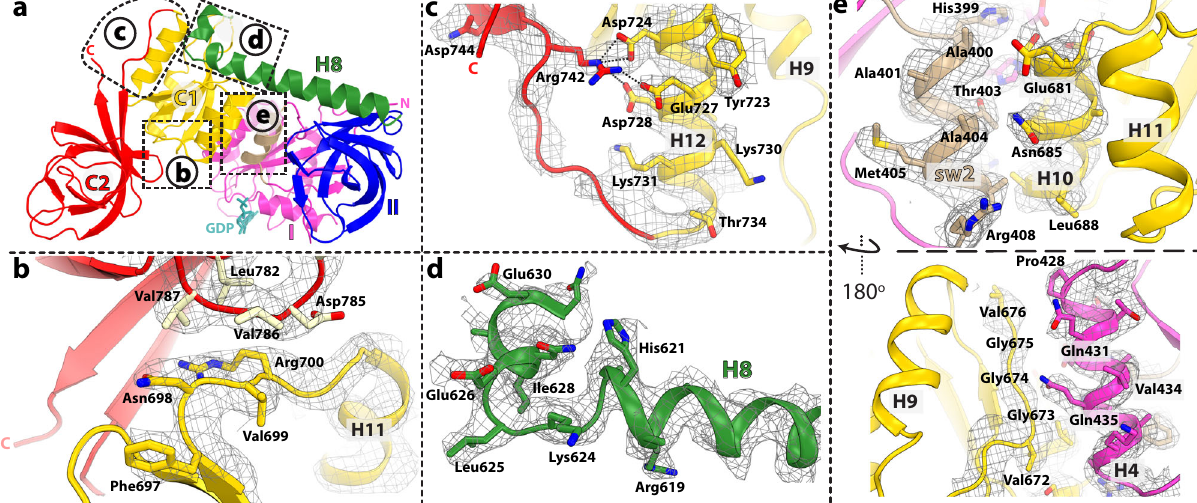
Fig. 4 Interactions between domains in compact IF2. a Overview of IF2-GDP with inset boxes indicating close-up views. b Residues Asn 698 , Val 699 , and Arg 700 in domain C1 (yellow) form a fl at surface that stacks with β -hairpin residues Leu 782 , Asp 785 , Val 786 , and Val 787 in domain C2 (red). EM density is shown as gray mesh. c Residues 735 – 742 form the linker between domains C1 (yellow) and C2 (red), which turns sharply by 180°. The last residue of the linker region (Arg 742 ) interacts with the negative patch lining one side of helix H12 in domain C1. d EM density (gray mesh) of helix H8 (green) around residue Leu 625 . The 90° − turn of helix H8 is required to accommodate the new location of domain C1 in IF2-GDP. e Two views of the interface between the G-domain and domain C1. The β -strand Val 672 -(Gly) 3 -Val 676 (lower panel) and helix H10 (upper panel) in domain C1 form the interface with H4 (lower panel) and the sw2- α -helix (upper panel) in the G-domain, respectively.